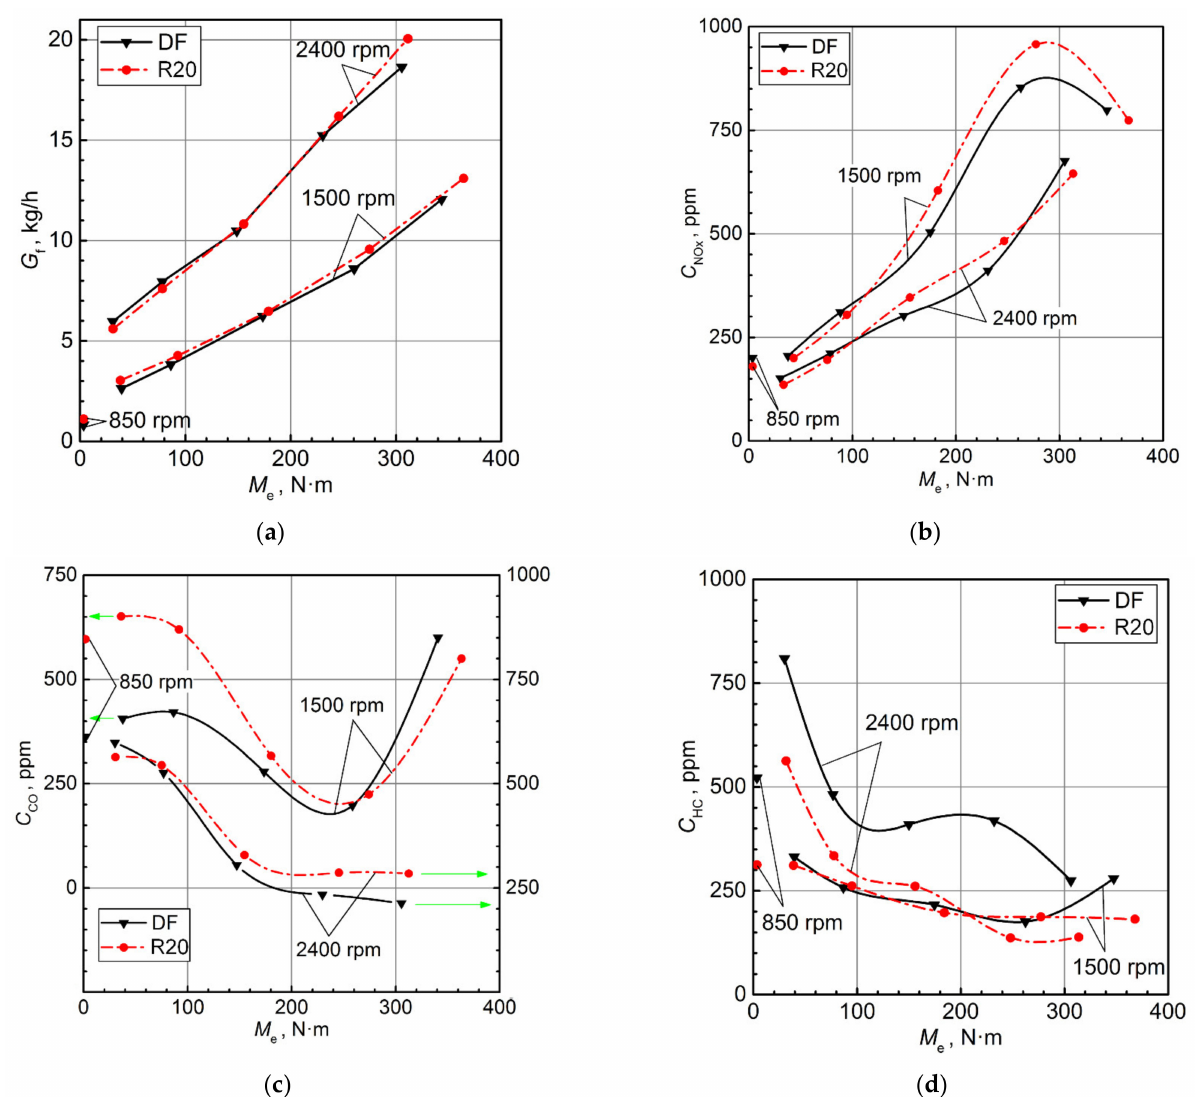
Figure 6. Dependence of hourly fuel consumption Gf ( a ), volumetric concentrations of nitrogen oxides CNOx ( b ), carbon monoxide CCO ( c ), and hydrocarbons CHC ( d ) in the exhaust gas on the engine speed and brake torque Me for pure DF and